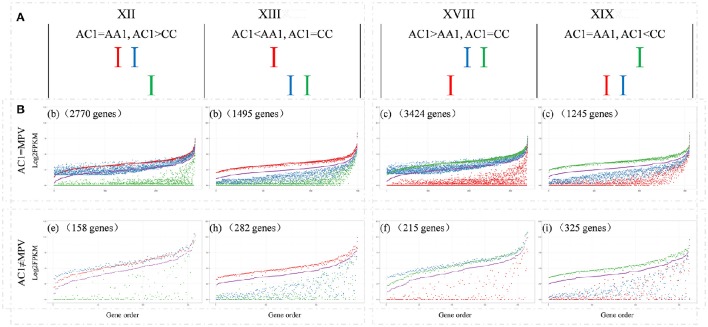
Comparisons of the expression levels of genes showing expression level dominance in AC1. (A) The four expression level dominance patterns, for which the gene expression level in hybrid AC1 is statistically similar to one parent but different from other parent. (B) The normalized expression values, measured in hybrid, the MPV and two progenitors, for genes from the four expression patterns are plotted to illustrate the expression level dominance. The y-axis represents log2 of the expression level (FPKM). Genes are ordered on the x-axis according to increasing FPKM of their MPV. The number of genes in each comparison is also indicated. Different colors indicate different species as described above, Red, AA1; green, CC; blue, AC1; purple, MPV.